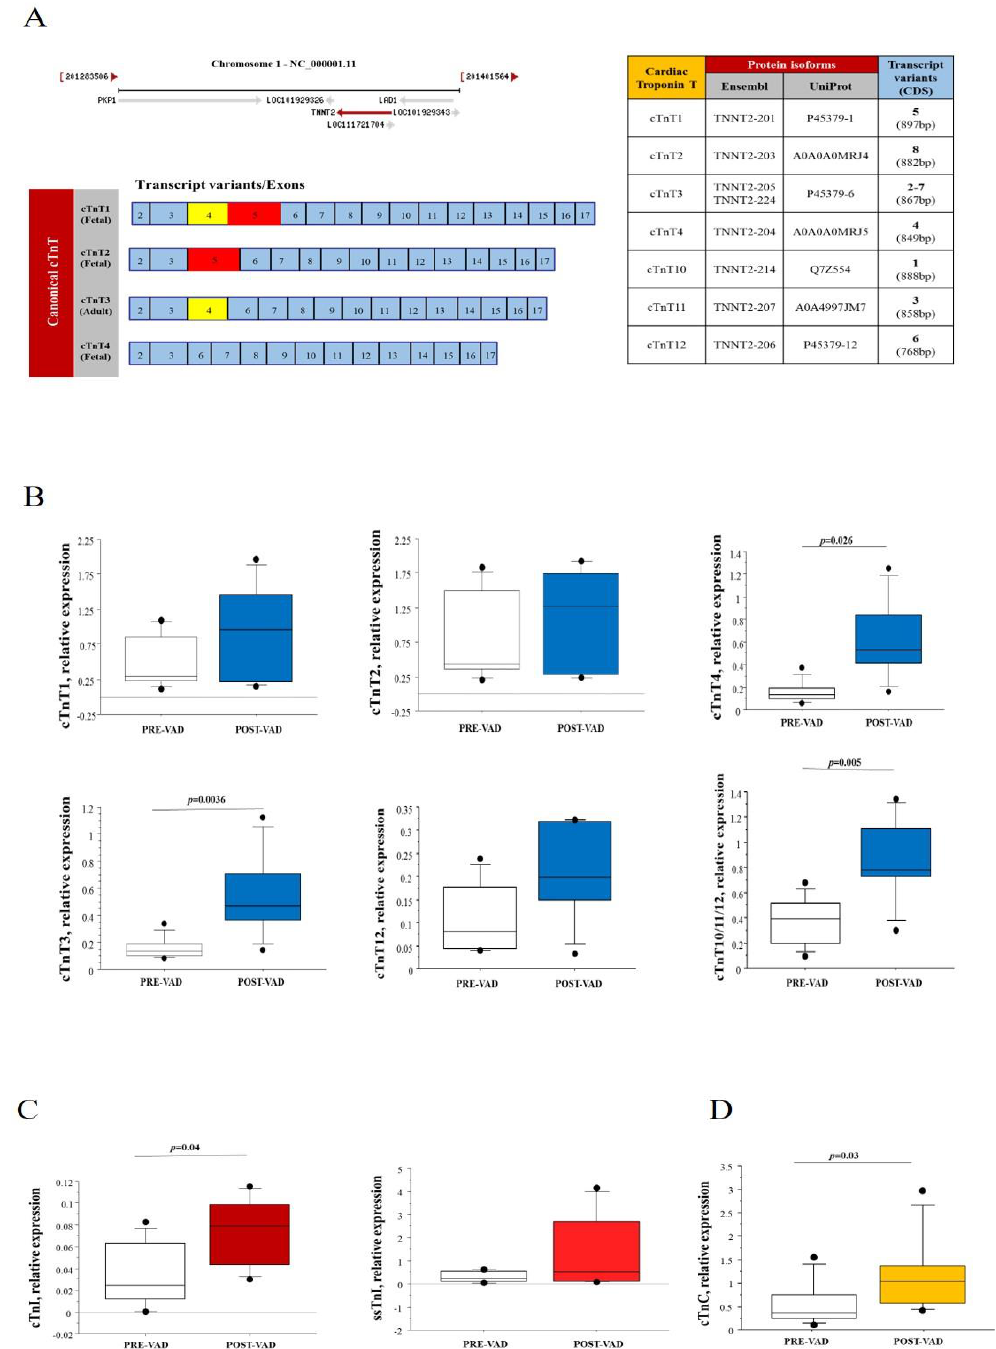
Figure 4. ( A ) Human cardiac troponin T gene (TNNT2) obtained from www.ncbi.nlm.nih.gov/gene, are at the top left, the canonical transcript variants of cardiac troponin T (cTnT) are at the lower left, fetal variants cTnT1, cTnT2 and cTnT4 and adult variant cTnT3 were obtained by splicing of exons 4 and/or 5. All canonical and non-canonical transcript variants and corresponding protein isoforms matched using Uniprot and Ensembl database in the table at the right. ( B ) Changes in canonical and non-canonical cTnT expression levels in HF children supported by VAD: comparison among pre-VAD and post-VAD samples. ( C ) Changes in cardiac troponin I (cTnI) and slow-skeletal troponin I expression levels in pediatric patients with HF treated with VAD: comparison among pre-VAD and post-VAD samples. ( D ) Comparison of cardiac troponin C expression levels between pre-VAD and post-VAD samples obtained from children with HF supported by